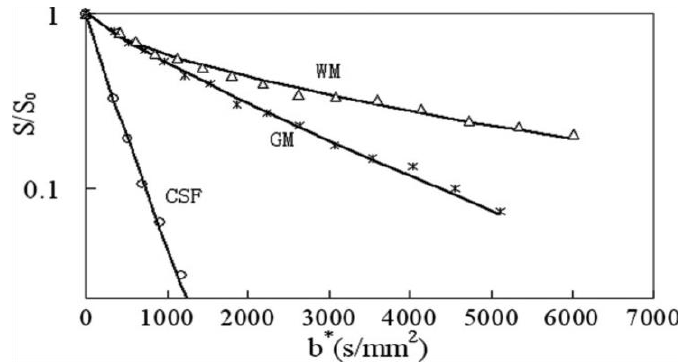
Figure 1. Normalized signal intensity plotted versus b for selected regions of interest (ROI) in white matter (WM), gray matter (GM) and cerebrospinal fluid (CSF) for a human brain (reprinted from ref. [13] with permission). DW-EPI T2-weighted image at 3.0 Tesla, TR / TE = 4000 / 97 ms, FOV = 22 cm · 22 cm, matrix 128 · 72 (zero padded to 256 · 256 during image reconstruction), in plane resolution = 1.72 mm × 3.05 mm and slice thickness = 4 mm. The experimental data were fit to the fractional order stretched exponential model, S(b) = S 0 exp[( − bD) α )], (WM, α = 0.64, D = 0.41 × 10 − 3 mm 2 / s ; GM, α = 0.82, D = 0.66 × 10 − 3 mm 2 / s ; CSF, α = 0.95, D = 2.72 × 10 − 3 mm 2 / s).